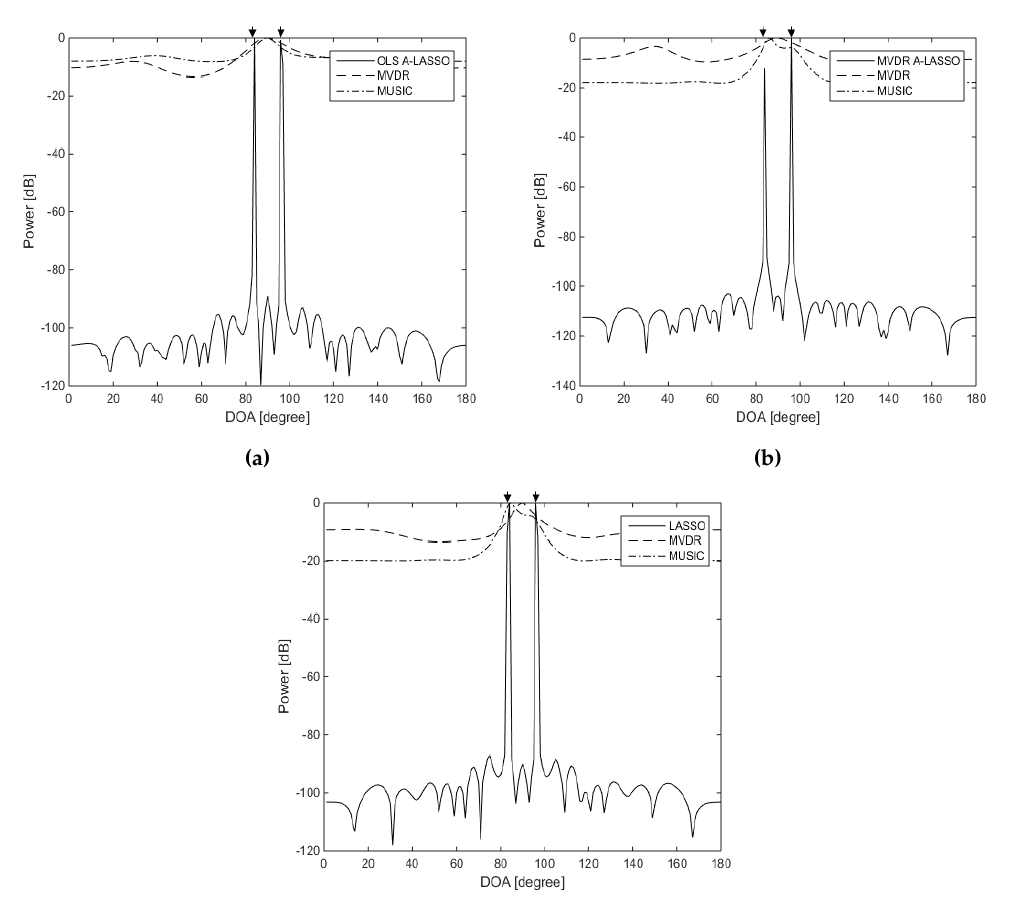
Figure 9. DOA estimation for spatially-closed two-source signals using LASSO algorithms, for two source signals at DOAs 85 ◦ and 95 ◦ , 10 snapshots, SNR = 15 dB and one iteration of the MVDR A-LASSO and OLS A-LASSO algorithms. ( a ) OLS A-LASSO after the first iteration; ( b ) MVDR A-LASSO after the first iteration; and ( c ) the classical LASSO